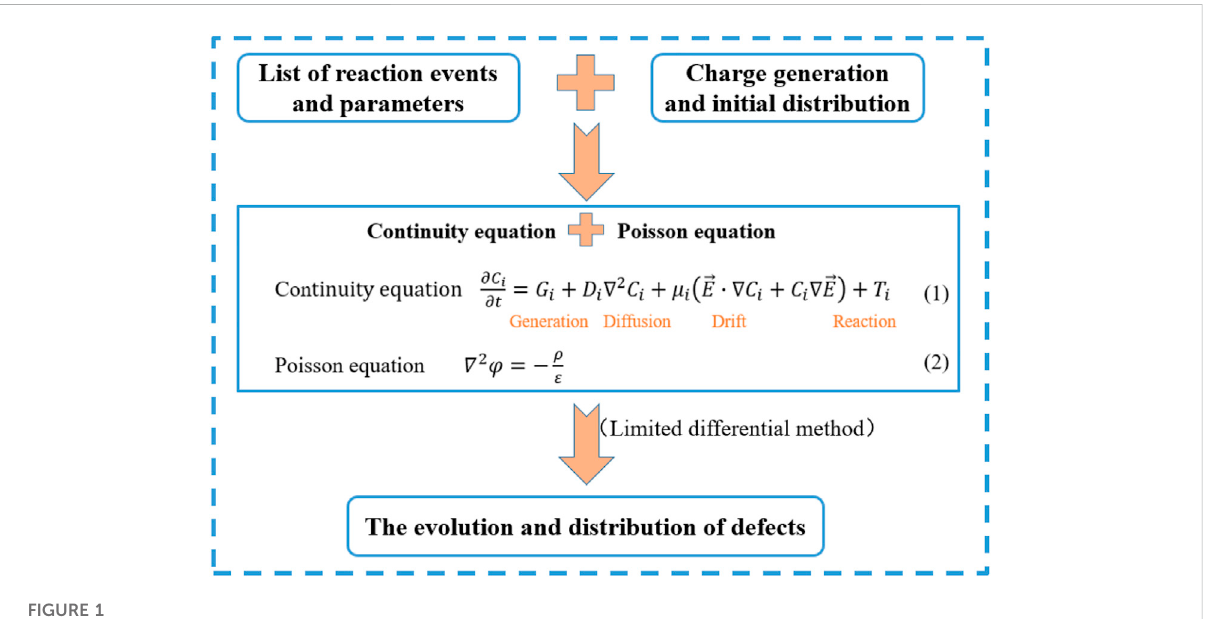
FIGURE 1 Diagram framework of the dynamic model.